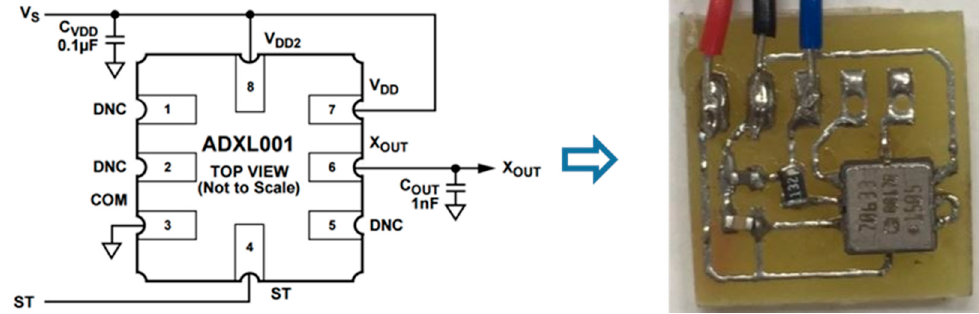
Figure 2. The circuit layout of the low ‐ pass filter. DNC: Do Not Connect; ST: Self Test.